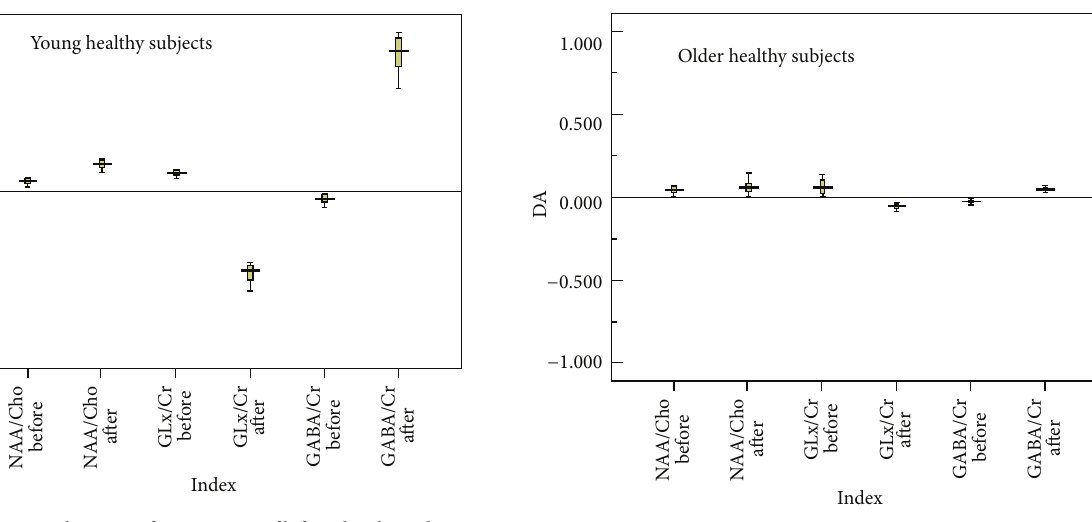
Figure 4: Schematic diagram of asymmetry of left and right auditorycorticalmetabolitesintheoldergroupbeforeandafterpure tone stimulation. Degree of asymmetry > 0 indicates that the content of the auditory cortical metabolite on the left side is higher than that on the right side, whereas degree of asymmetry < 0 indicates that the content of the auditory cortical metabolite on the right side is higher than that on the left side. Abbreviations: DA, degree of asymmetry; Cho, choline-containing compounds; Cr, creatine- containing compounds; Glx, glutamine/glutamate; NAA, N-acetyl-